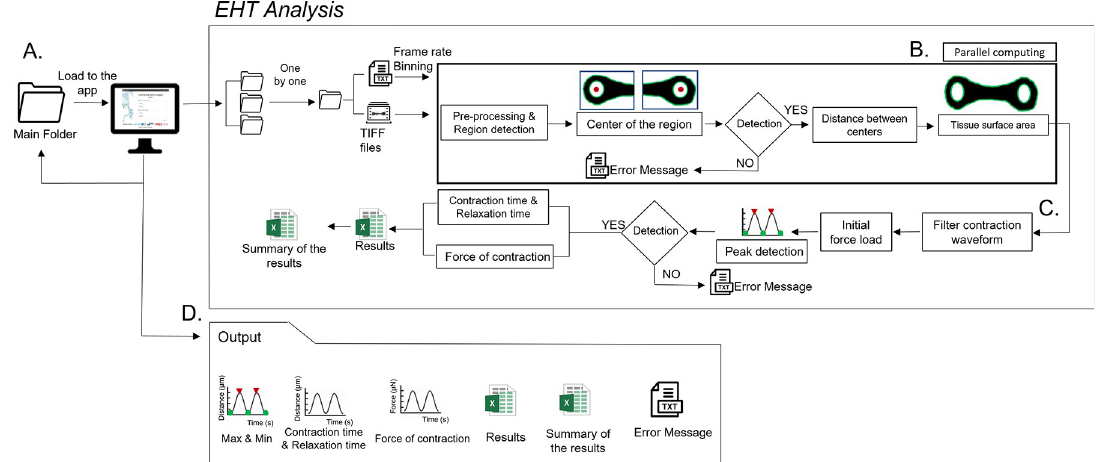
Fig 3. Flow chart representing the workflow of EHT analysis . (A) Automatic analysis of the required input data inside of a main folder. (B) Tracking the center of the pillars and the surface area, using parallel computing. (C) Contraction waveform post-processing. (D) Output